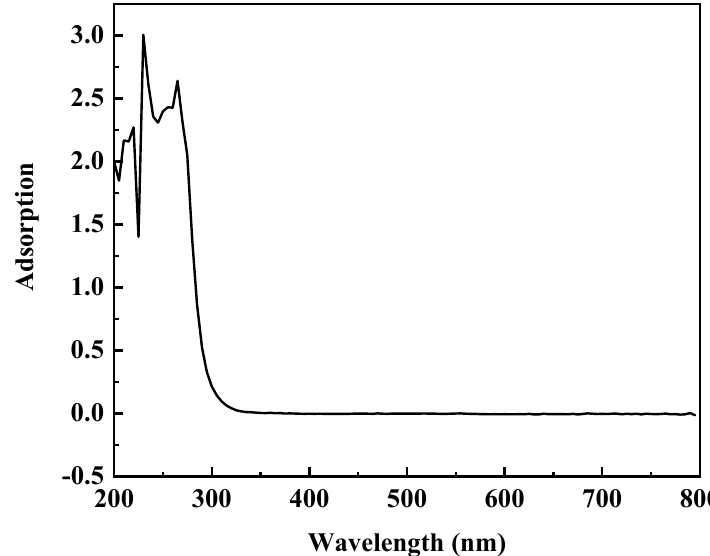
Figure 8. The adsorption spectrum of Ag–Cu thiosulfate complexes ([Ag] = 500 mg/L, [Cu] = 50 mg/L, [S 2 O 32 − ] = 0.1 mol/L, 298 K, uncontrolled pH).